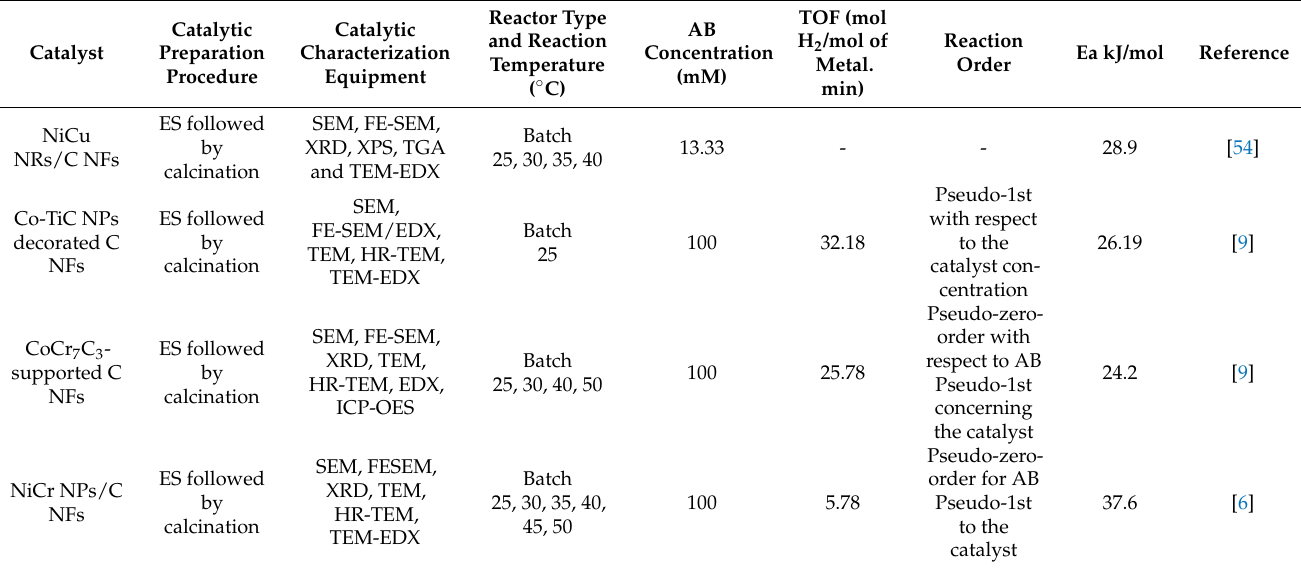
Table 2. Catalytic data of C NF-supported catalysts for AB hydrolysis.